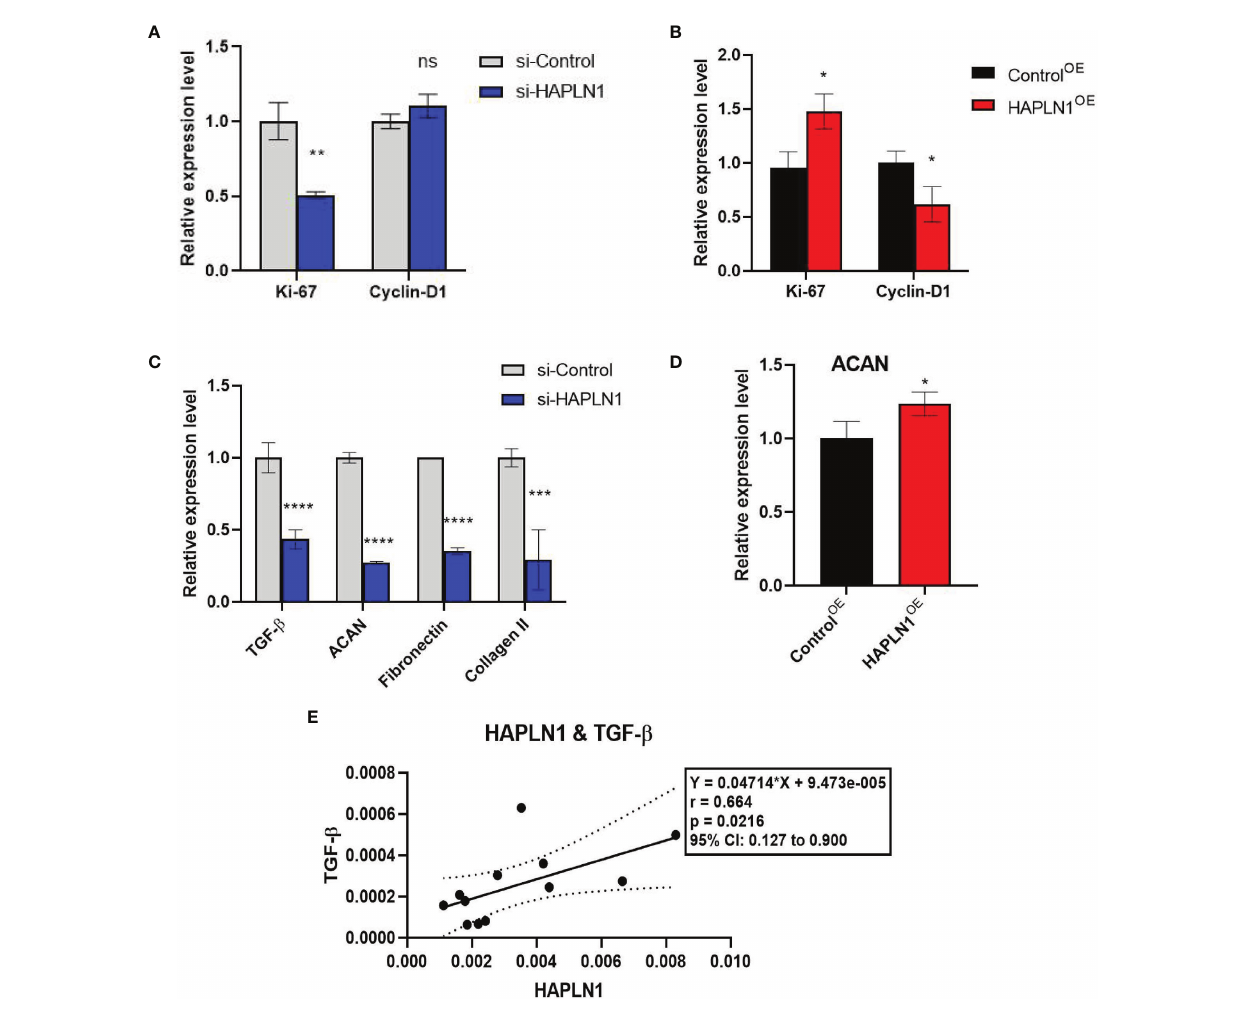
FIGURE 5 | The effects of si-HAPLN1 and HAPLN1 OE on RA-FLS-derived cell-cycle and structure molecules. (A) si-HAPLN1 transfection decreased Ki-67 mRNA expression signi fi cantly, (B) HAPLN1 OE transfection increased Ki-67 but down-regulated Cyclin D1 expression in RA-FLSs. (C) Expression of mRNA of TGF- b , ACAN, fi bronectin, and collagen II were down-regulated by si-HAPLN1 treatment in RA-FLSs, while (D) ACAN was signi fi cantly up-regulated by HAPLN1 OE transfection. (E) Pearson correlation coef fi cient analysis showed relative mRNA levels from the si-control group, with a strong positive correlation (r = 0.66, 95%CI [0.13, 0.90], p < 0.05) between TGF- b and HAPLN1. *p < 0.05; * *p < 0.01; ** *p < 0.001; *** *p < 0.0001; ns, not signi fi